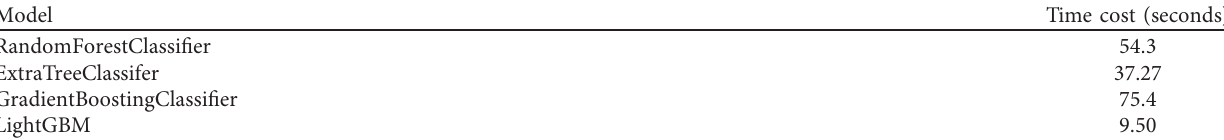
Table 5: Training time comparison.